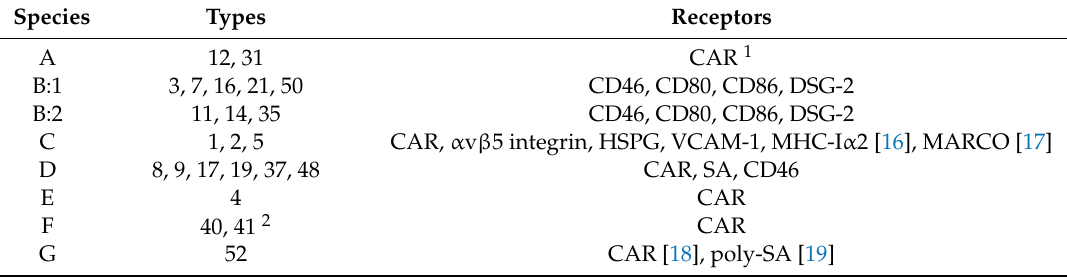
1 Abbreviations: CAR: coxsackie and adenovirus receptor. DSG-2: desmoglein-2. HSPG: heparan sulphate proteoglycan. VCAM-1: vascular cell adhesion molecule 1. MHC1 α 2: major histocompatibility complex-1 α